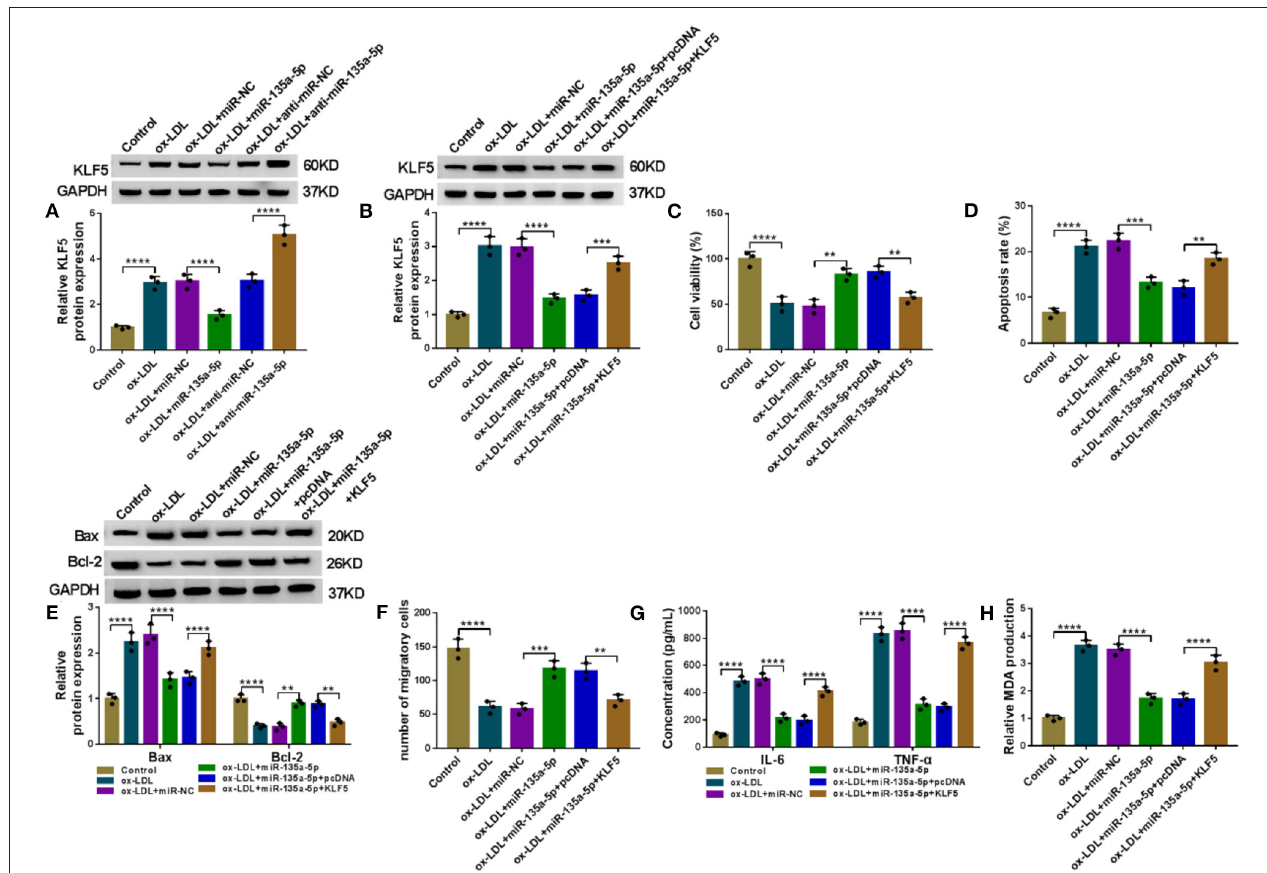
FIGURE 6 | The alleviative effects of miR-135a-5p overexpression on ox-LDL-triggered HUVEC injury were abated by KLF5 expression restoration. (A) KLF5 protein expression determined by western blot in HUVECs transfected with miR-NC mimic, miR-135a-5p mimic, anti-miR-NC, or anti-miR-135a-5p before stimulation with ox-LDL (40 µ g/ml, 24h). HUVECs were transfected with miR-NC mimic, miR-135a-5p mimic, miR-135a-5p mimic + pcDNA, or miR-135a-5p mimic + KLF5 before ox-LDL stimulation (40 µ g/ml, 24h), followed by the determination of KLF5 protein level by western blot (B) , cell viability by CCK-8 assay (C) , cell apoptosis by flow cytometry (D) , Bax and Bcl-2 levels by western blot (E) , cell migration by Transwell assay (F) , and IL-6, TNF- α , and MDA levels by ELISA (G,H) . pcDNA: negative control, KLF5: KLF5-overexpressing plasmid. n = 3 independent biological replicates; error bars represented SD; ** P < 0.01, *** P < 0.001, or **** P < 0.0001 by one-way ANOVA with Tukey’s post hoc